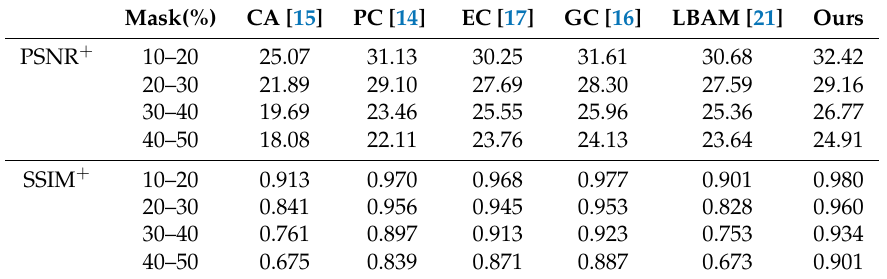
Table 5. Comparison results of different methods in terms of different ratios of mask on CelebA-HQ.